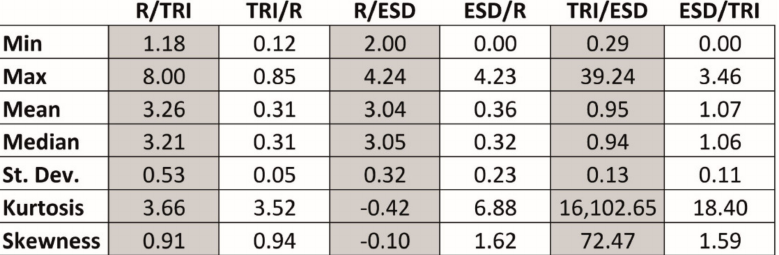
Figure 10. Matrix showing the two-by-two joint comparisons between R, ESD, and TRI variables. The x-axis represents values normalized considering the minimum and maximum values of the ratios